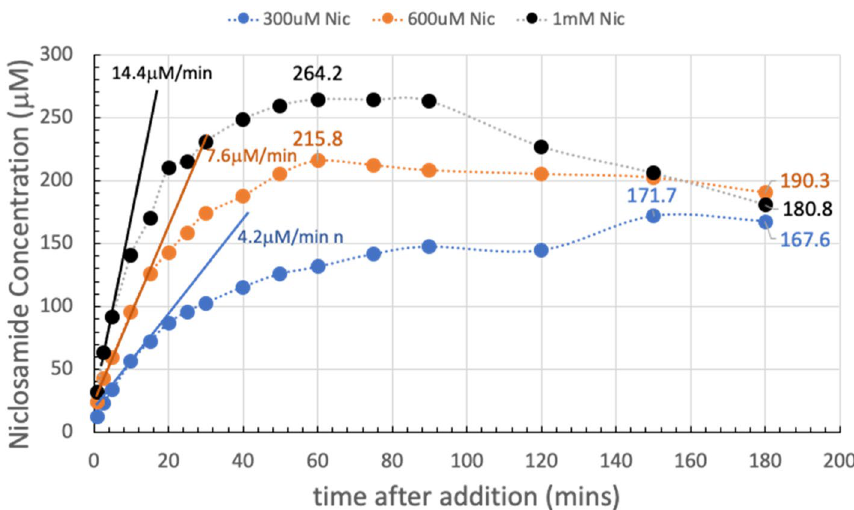
Fig. 5 Summary of concentration data at pH 9.35 (0–180 min). Dissolution of Yomesan-niclosamide at niclosamide equivalents of 300 µM, 600 µM, and 1 mM in nominal 9.33 TB (final pHs ~ 9.2). 180-min time points average to 179.4 µM